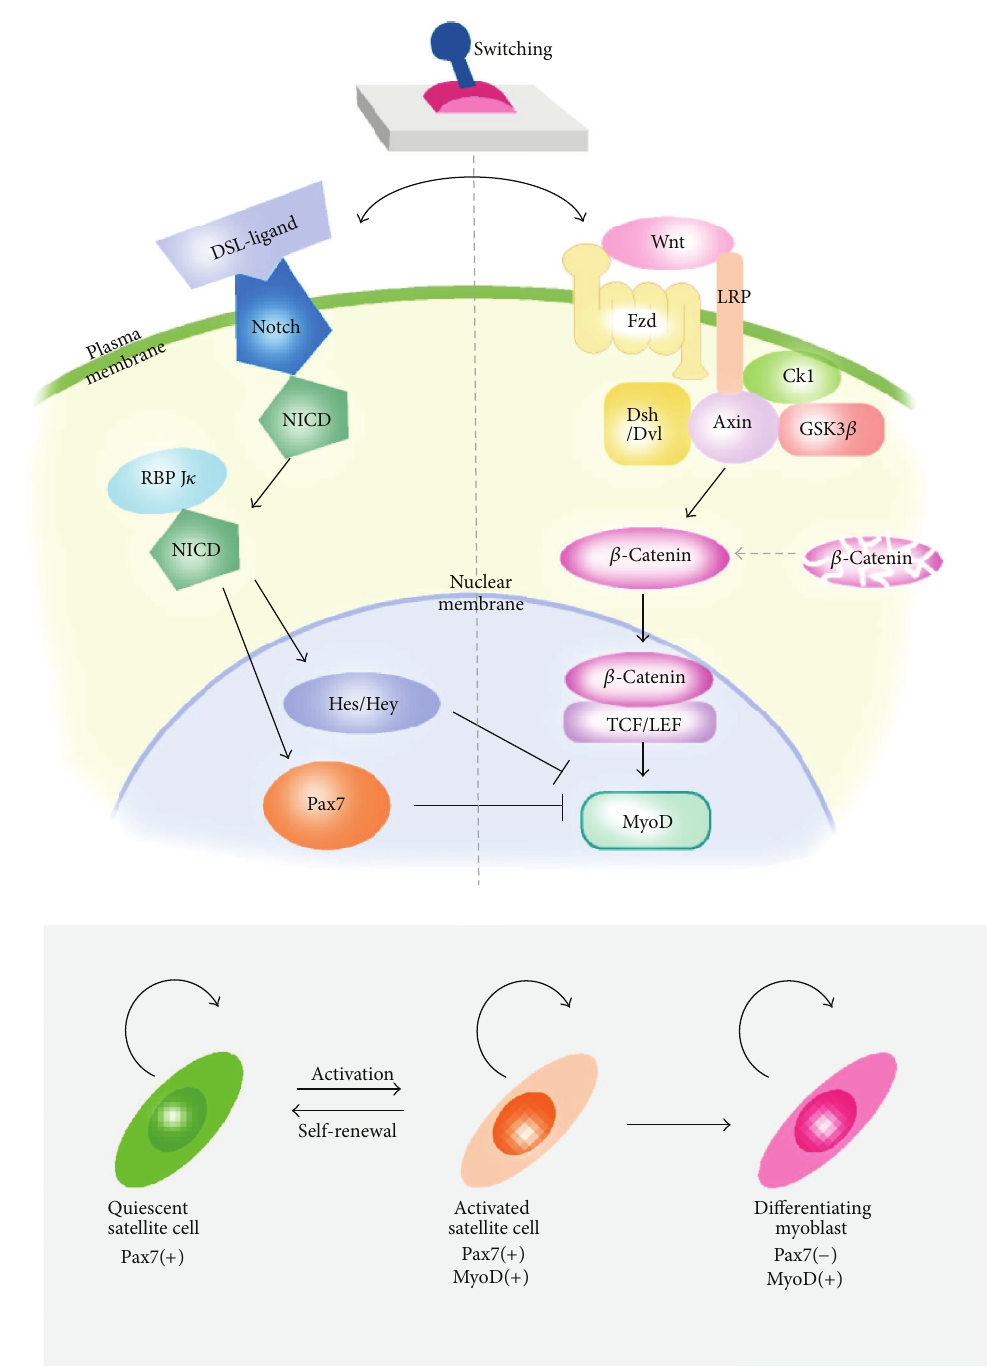
Figure 2: Regulatory switch between quiescent and activated states of satellite cells. Notch and Wnt signaling antagonize each other to define the state of satellite cells. Upon binding of DSL ligands (Delta) to Notch receptor, released Notch intracellular domain (NICD) translocates to the nucleus. After associating with RBP-J 𝜅 , the complex activates the transcription of target genes, such as Hes, Hey, and Pax7 to maintain satellitecellsinquiescentstate(left).Whenthe“molecularswitch”turnsfromthequiescentstatetotheactivationstatebyWntproteins(right), the Wnt signal transduction activates 𝛽 -catenin/TCF/LEF transcriptional complexes. The transcription complex triggers the expression of target MyoD gene and positively regulates myogenic